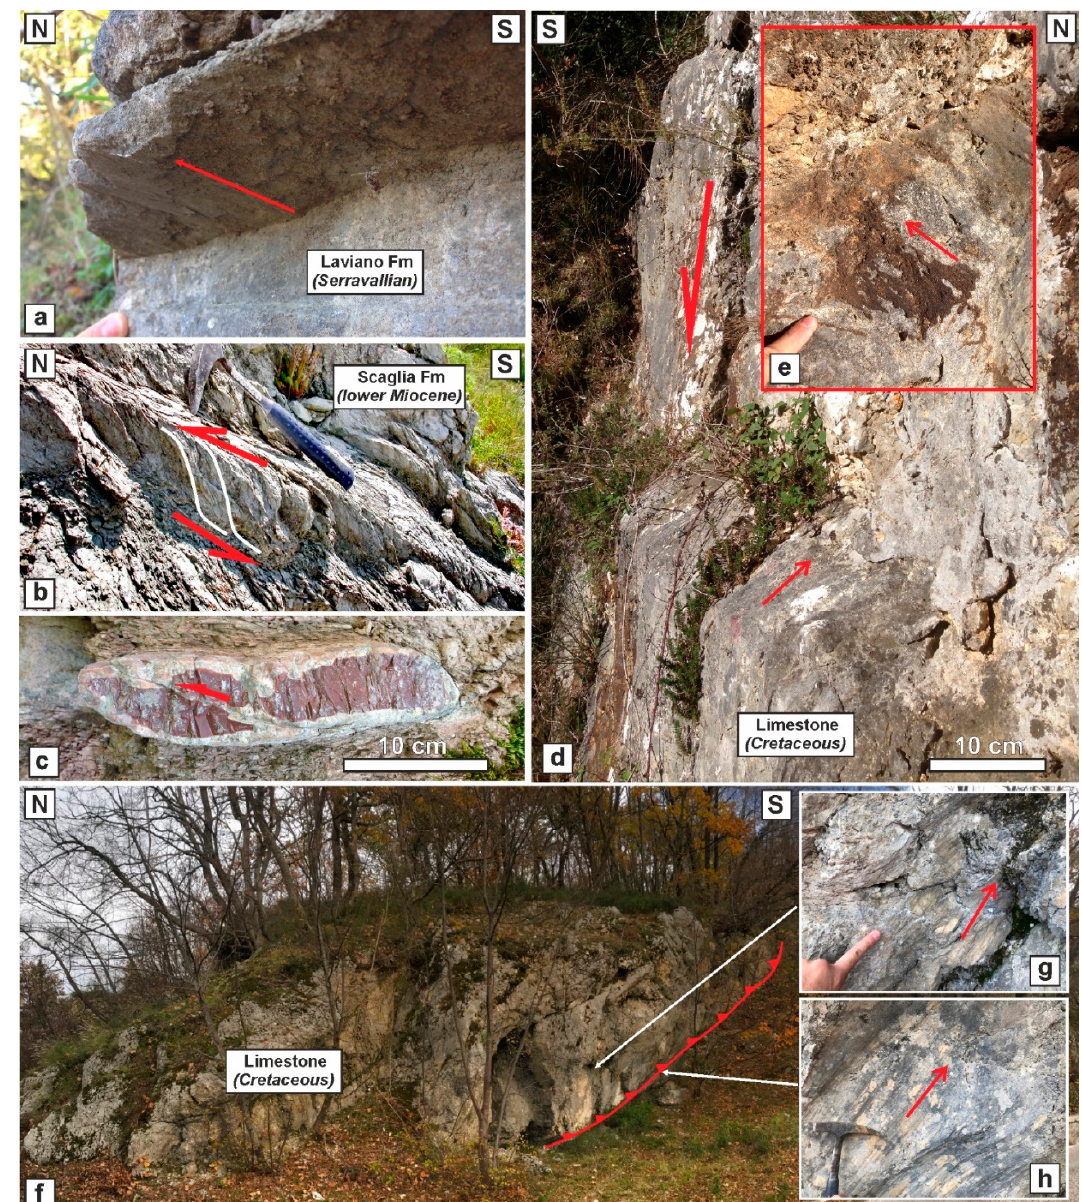
Figure 4. Laviano: ( a ) thrust fault in calcarenites of the Laviano Fm.; ( b ) S-C structures associated to a north-verging thrust within the gray Scaglia Fm; ( c ) pre-buckle thrust in red chert within the Scaglia Rossa Fm; ( d , e ): normal fault plane crosscut by north-verging thrust faults. Bagnoli Irpino: ( f ) back-thrust within the Cretaceous succession; ( g , h ) striations and steps.